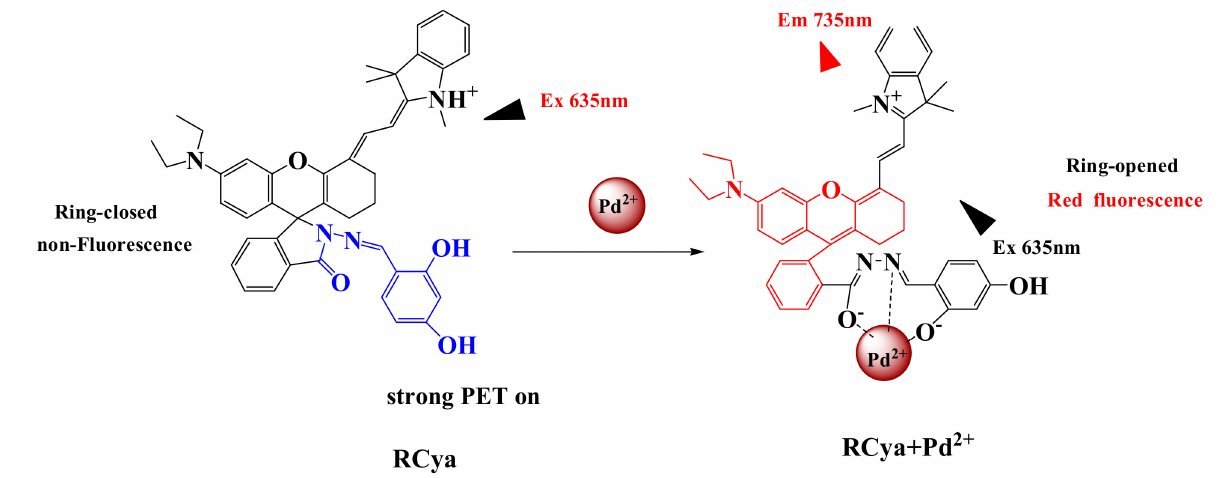
Figure 6. Proposed recognition mechanism of probe RCya to Pd 2+